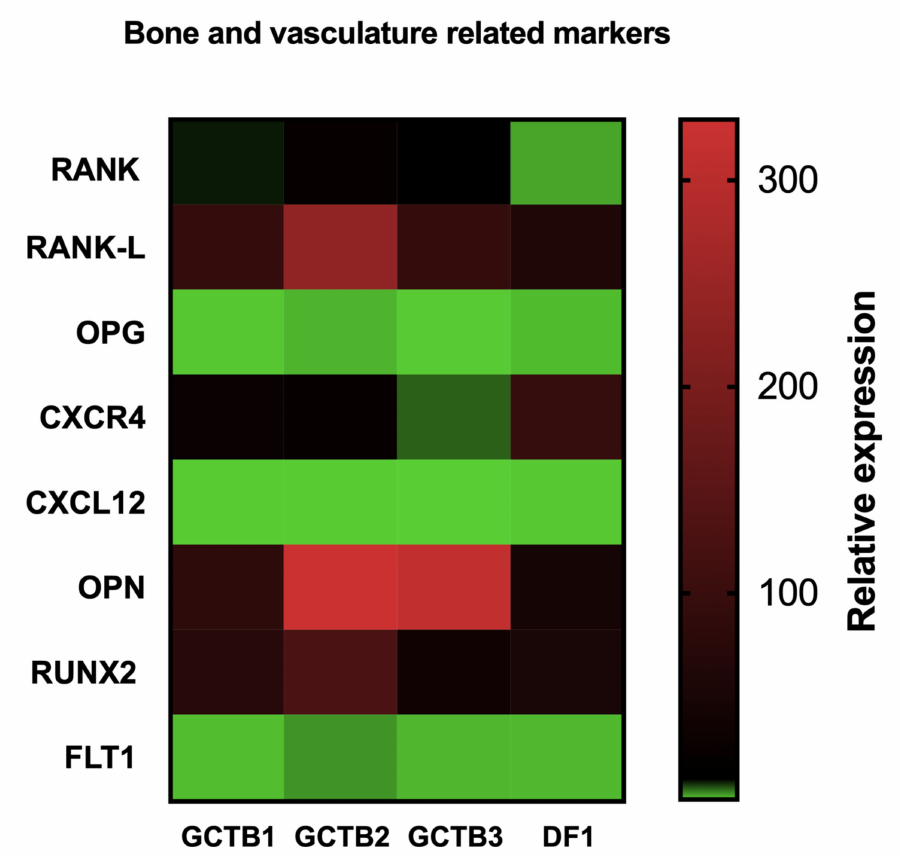
Figure 2. Heat map comparison of the relative gene expression of bone- and vasculature-related markers in GCTB and DF tumor tissue compared to the matched healthy